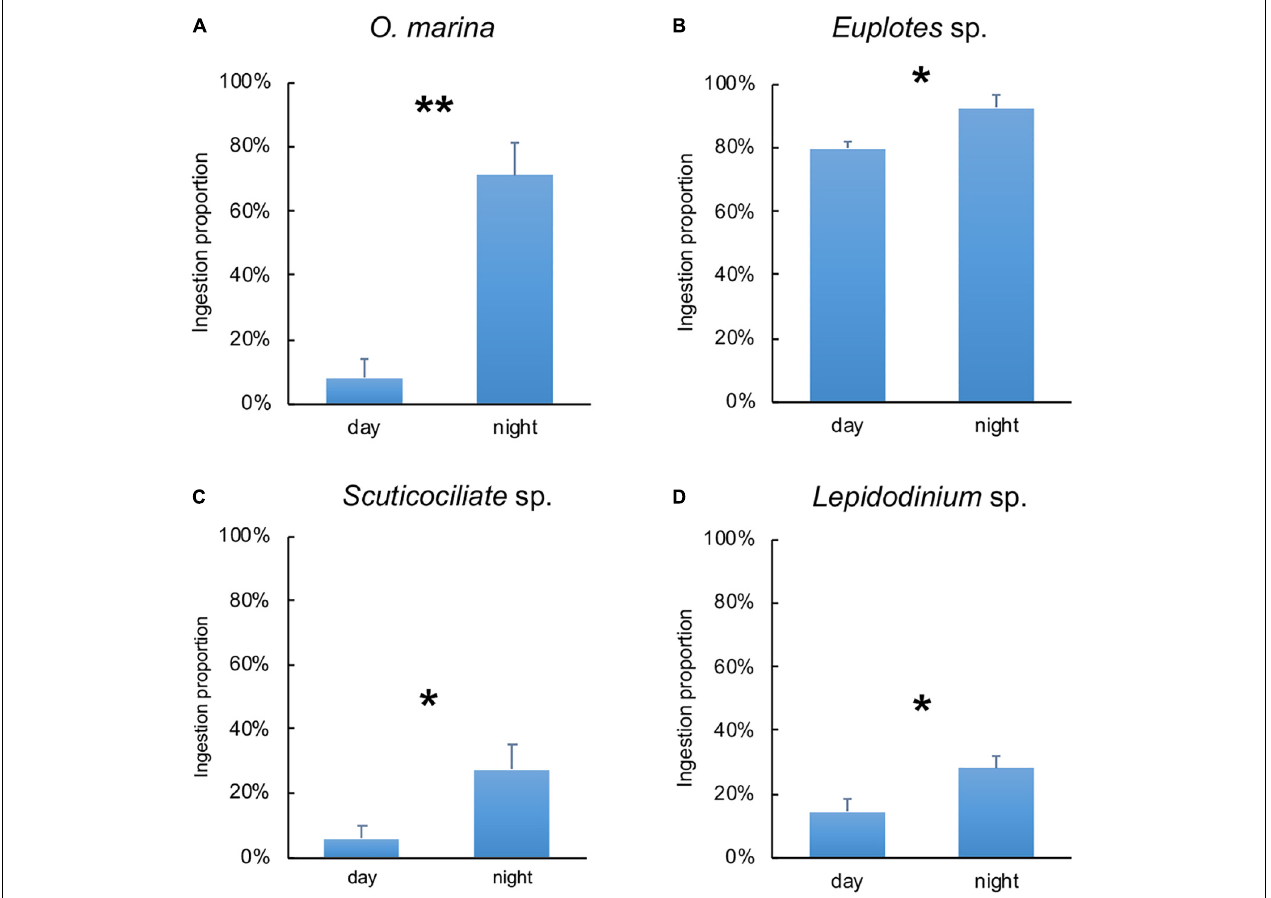
FIGURE 3 | Ingestion proportion of Oxyrrhis marina (A) , Euplotes sp. (B) , Scuticociliate sp. (C) and Lepidodinium sp. (D) on C. watsonii during daytime and nighttime. Values denote the mean ± standard error based on triplicates. Asterisks represent significant differences between ingestion proportion on C.